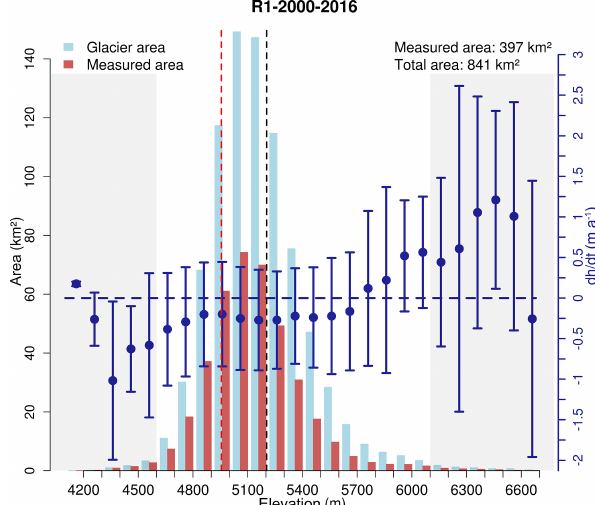
Figure 6. Hypsometric distribution of measured (red bars) and total (light blue bars) glacier area with elevation in subregion R1 in the interval 2000–2016. Blue dots represent the mean (cid:49)h/(cid:49)t value in each elevation interval. Error bars indicate NMAD of (cid:49)h/(cid:49) t for each hypsometric bin. Grey areas mark the lower and upper 1% quantile of the total glacier area distribution. Black dashed line: mean glacier elevation; red dashed line: equilibrium line altitude (ELA); see also Table S3. Area measurements are based on the glacier outlines from 2000, considering only regions with slopes below applied slope threshold (50 ◦ ; see Sect. 4.2). Plots for other subregions are provided in the